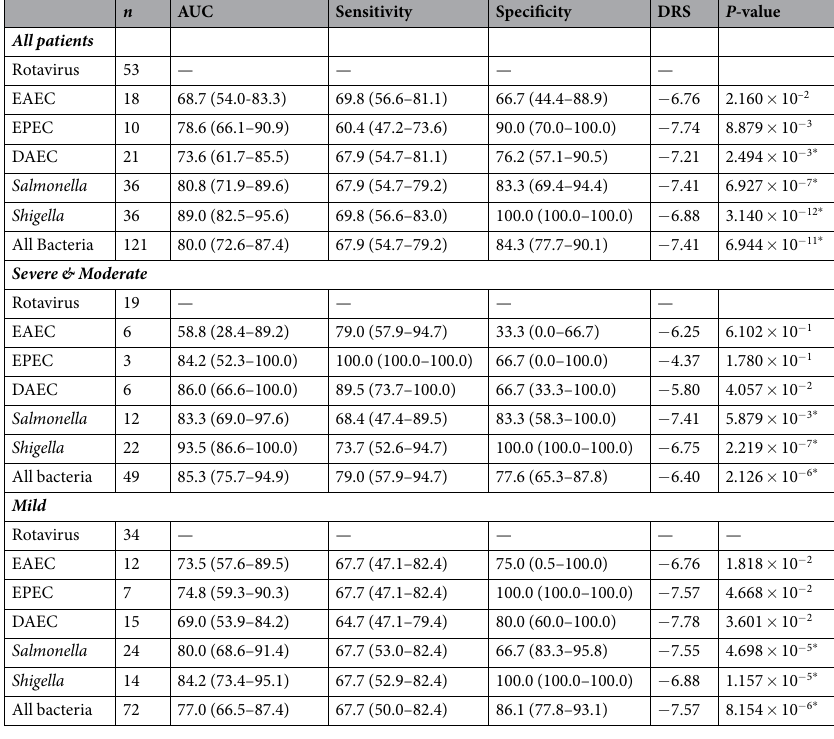
Table 1. AUC values and DRS for different pathogens. Figures in round brackets show the CI 95% (2,000 bootstrap replicates). P -values evaluate the significance of the difference between bacterial pathogen vs . viral infection under a t-test; an asterisk. ( * ) indicates those values surpassing a Bonferroni correction for multiple tests. Note that the reference viral pathogen in our study is rotavirus (for which there is only very little information available in the literature; e.g. 43